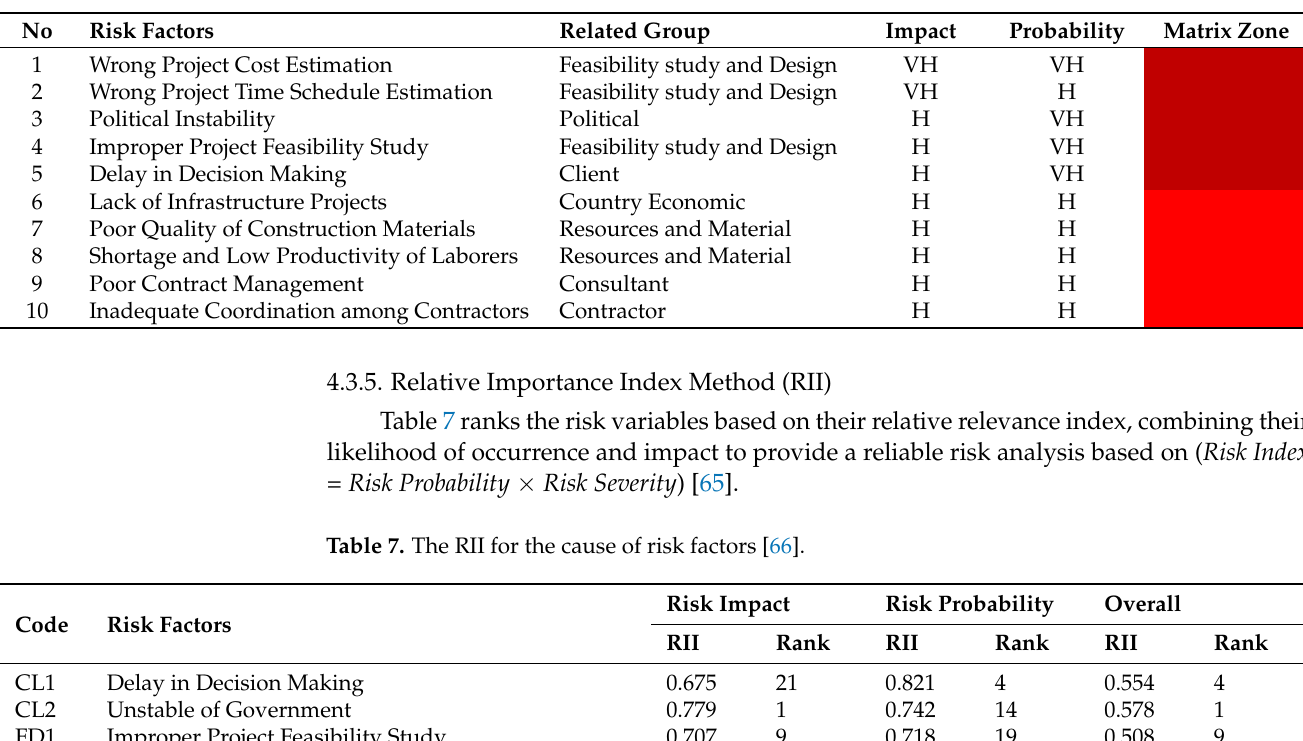
Table 6. Probability–Impact Matrix for top ten risk factors [38].